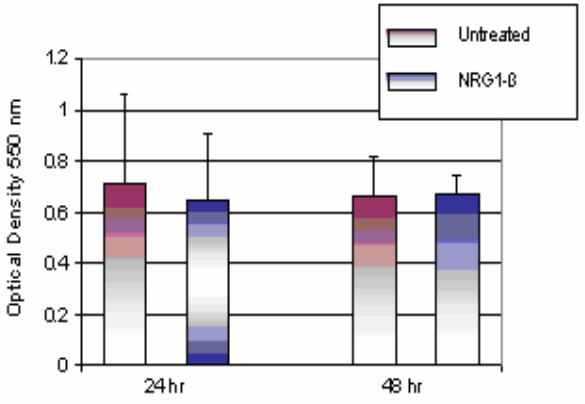
Figure 1: Comparison of untreated and NRG1- β - treated AML 12 mouse hepatocytes . NRG1- β -treated (10 nM NRG1- β ; 1:1000) hepatocytes were compared to untreated (0) cells for 24- and 48 h. Hepatocytes were maintained in DMEM medium with 10% FBS